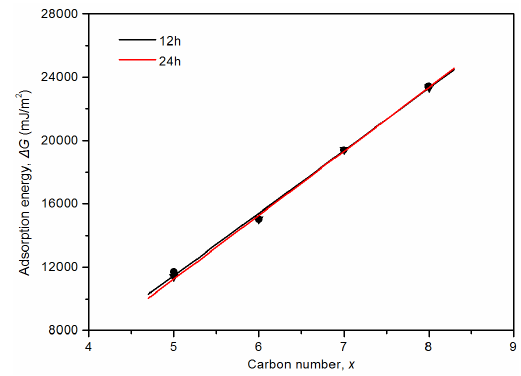
Figure 3: Effect of aging time of column on adsorption energy (30